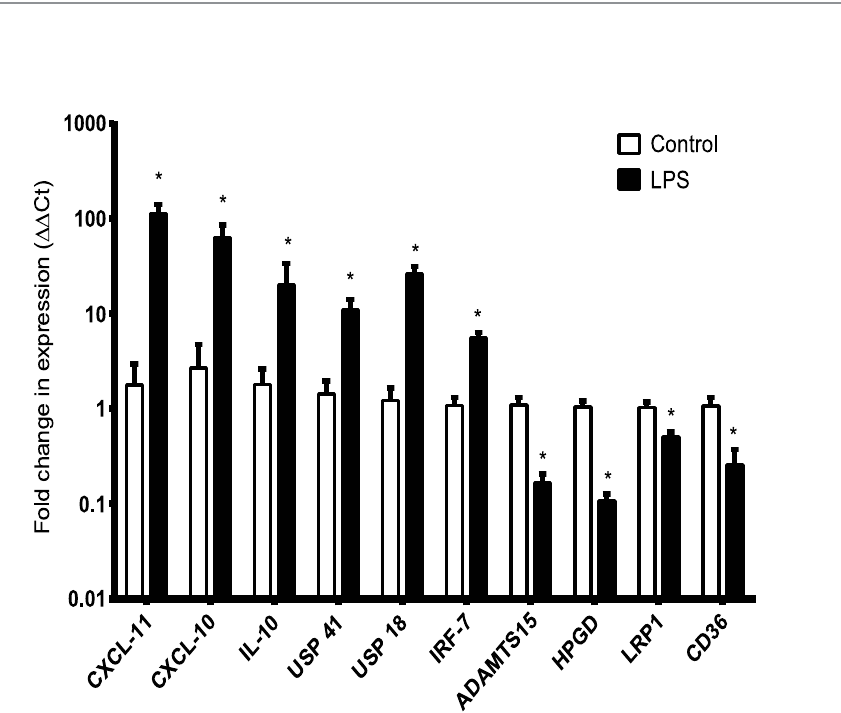
Fig 6. Validation of RNA-sequencing data by quantitative real-time PCR. Representative up-regulated and down-regulated target genes from the RNA-Seq data set were validated with real time quantitative PCR using the same samples used for RNA-Seq assays ( * p < 0.05 two-tailed t-test, vs. respective control, n = 4 – 5). Values represent mean (+/-) SEM of relative gene expression changes vs. 18S housekeeping gene, calculated by the ΔΔ Ct method. Human alveolar macrophages were stimulated in the presence or absence of LPS for 6 h.